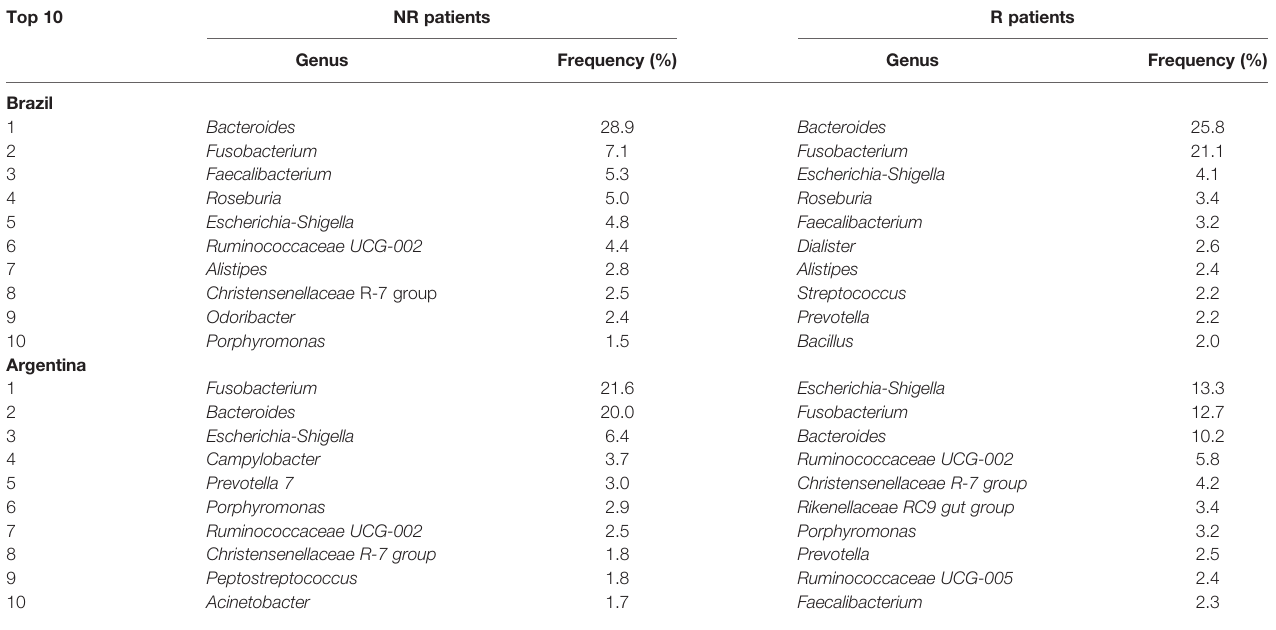
TABLE 2 | Top 10 genera identi fi ed in pre-treatment LARC biopsies according to the country of origin and patient ’ s response to neoadjuvant treatment (nCRT). Top 10 NR patients R patients Genus Frequency (%) Genus Frequency (%) Brazil